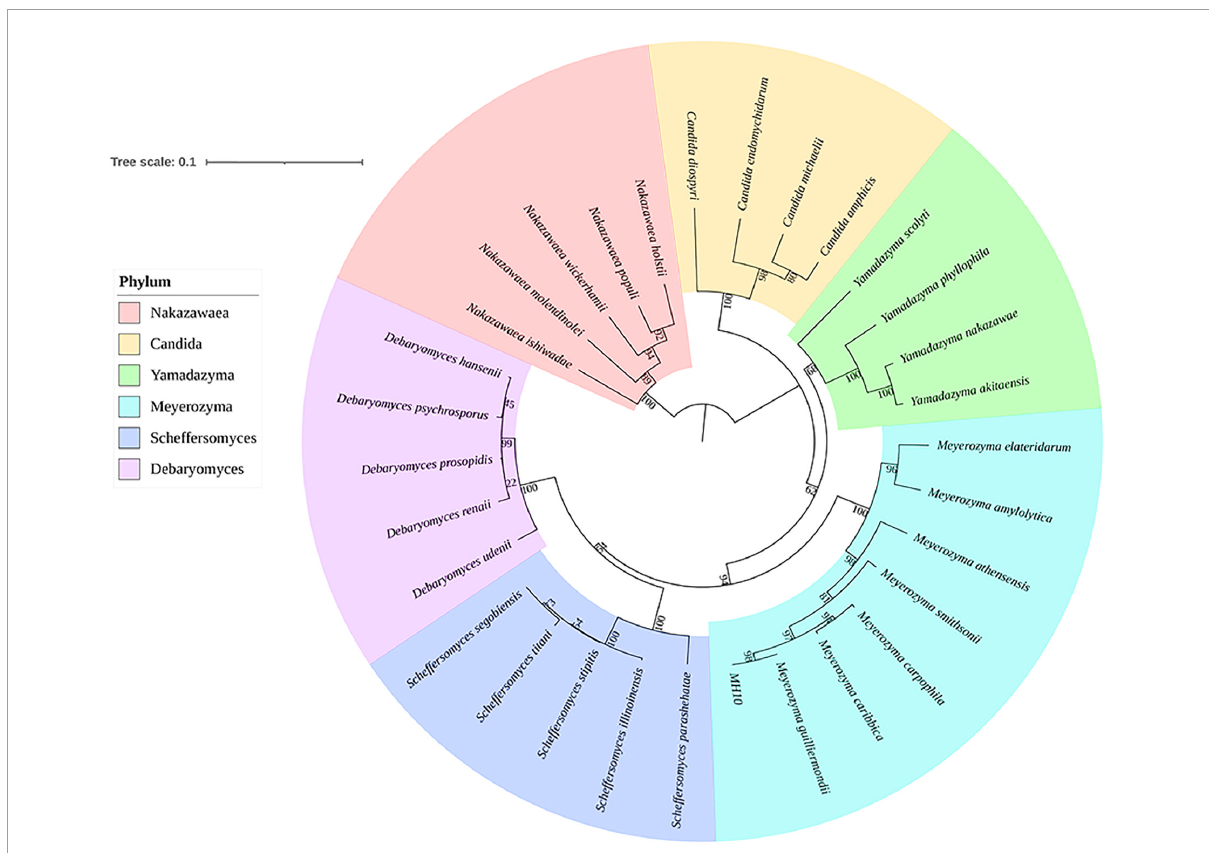
FIGURE4 Phylogenetic affiliation of MH10, based on the phylogenetic tree generated using Mega X software.